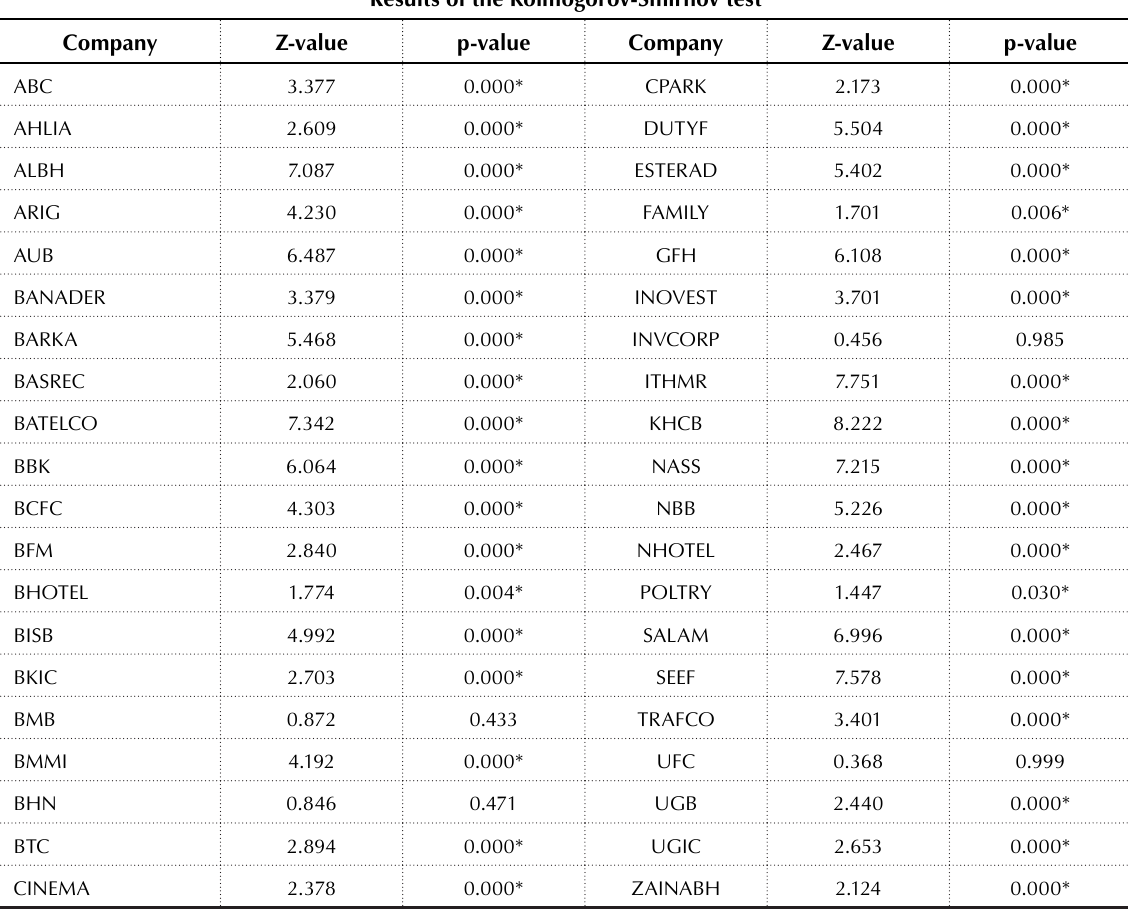
Table 2. Results of K-S